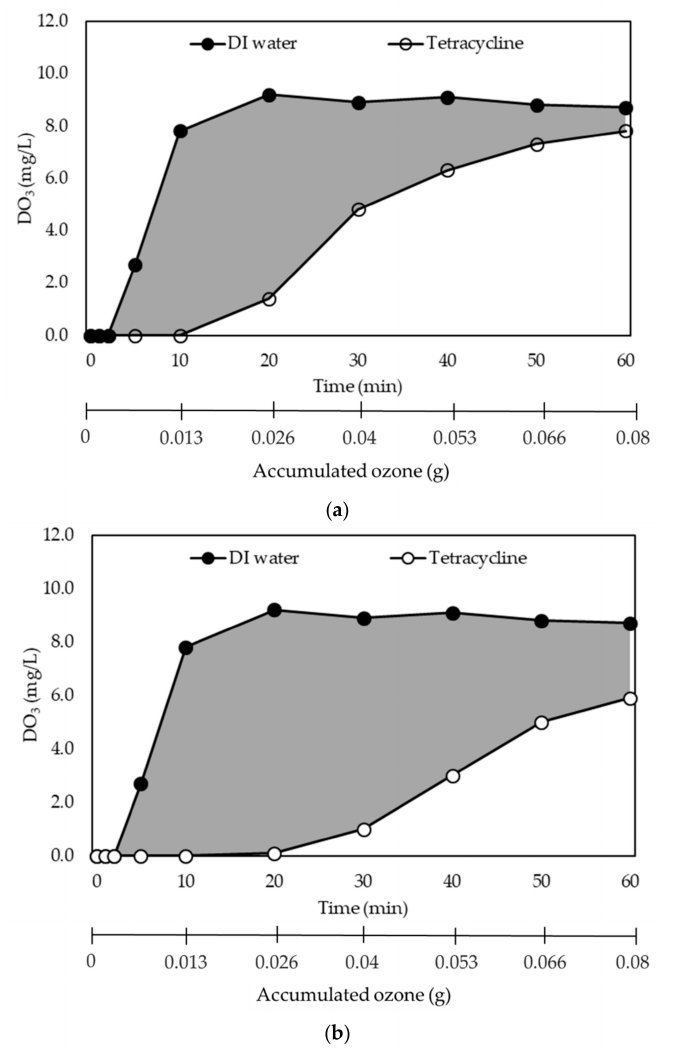
Figure 4. Ozone usage during tetracycline degradation calculated by integrating method at ( a ) pH 3 and ( b ) pH